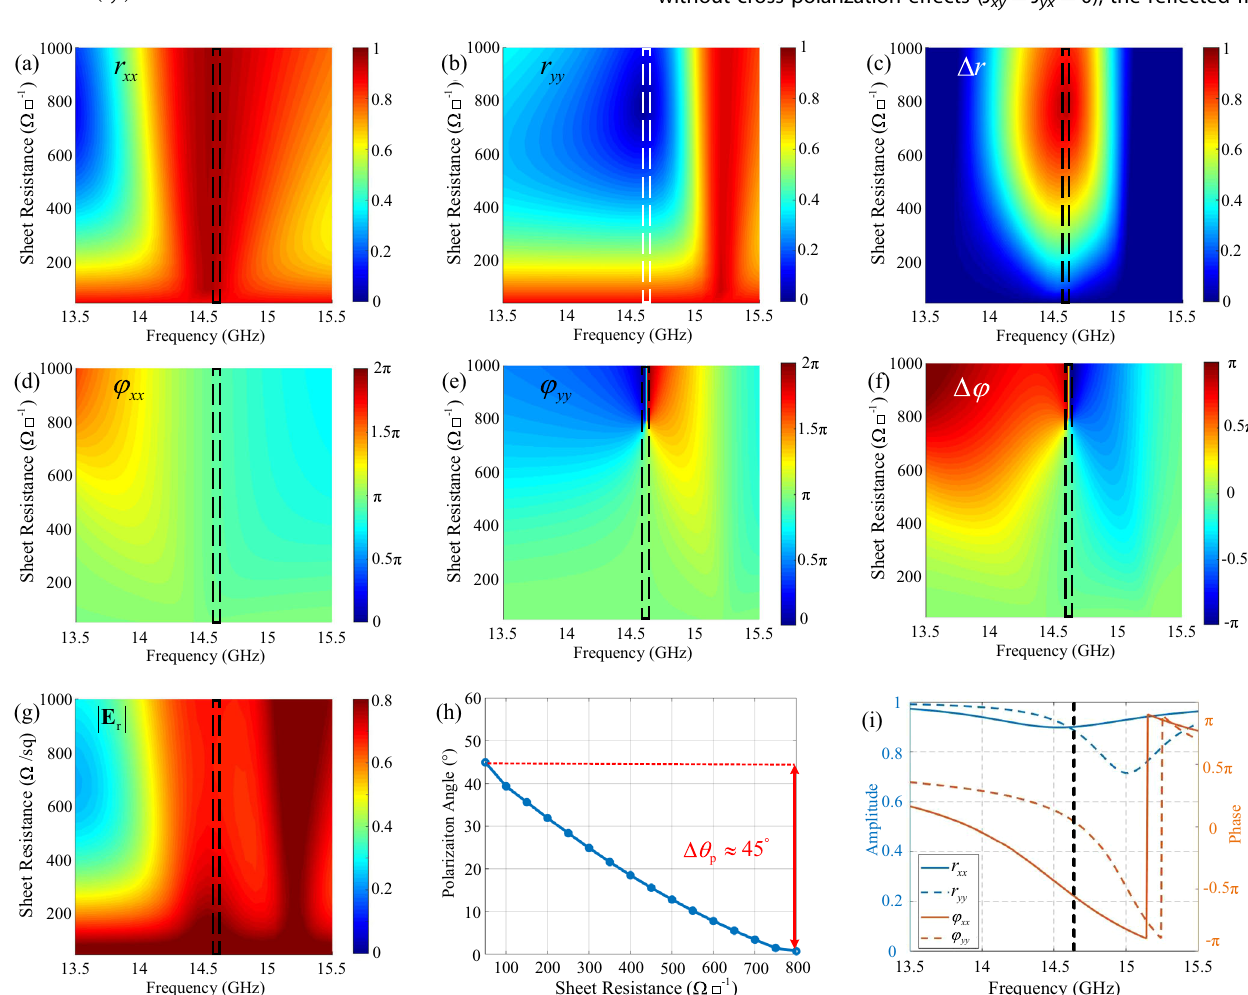
Fig. 3 Simulated results of graphene-based meta-device. Simulated re fl ected amplitude ( a , b ) and phase spectra ( d , e ) of the metasurface with a different sheet resistance of graphene under x - and y -polarized incident waves. Simulated amplitude ( c ) and phase difference ( f ) spectra as a function of sheet graphene's resistance. g The intensity spectra of the re fl ected electric fi eld. h The tunable polarization angle for sheet graphene's resistance. i Simulated amplitude and phase response of the proposed meta-device without graphene